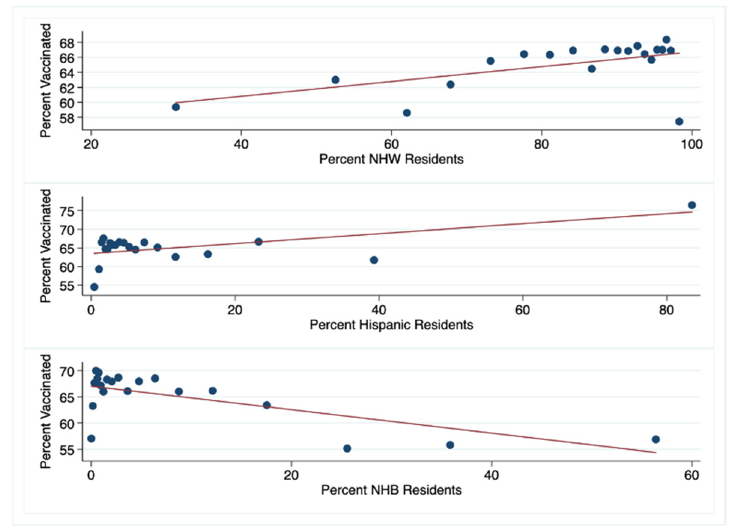
Figure 3. Binned scatter plots demonstrating the relationship between the rate of COVID-19 vac- cination for the 65 and older population and the percent of county residents that are NHW, Hispanic, and NHB. For each county, we compared the COVID-19 vaccination rate to the influenza vac- cination rate. There were 467 (14.5%) counties with COVID-19 vaccination rates lower than influenza rates. We compared these “lowvax” counties to “highvax” counties for which the COVID-19 vaccination rates exceeded the influenza rates ( n = 2756). Character- istics of the lowvax and highvax counties are presented in Table 1; highlights are summa- rized below. Table 1. Comparison of counties with COVID-19 vaccination rates lower (Lowvax) and higher (Highvax) than their influ- enza vaccination rates.